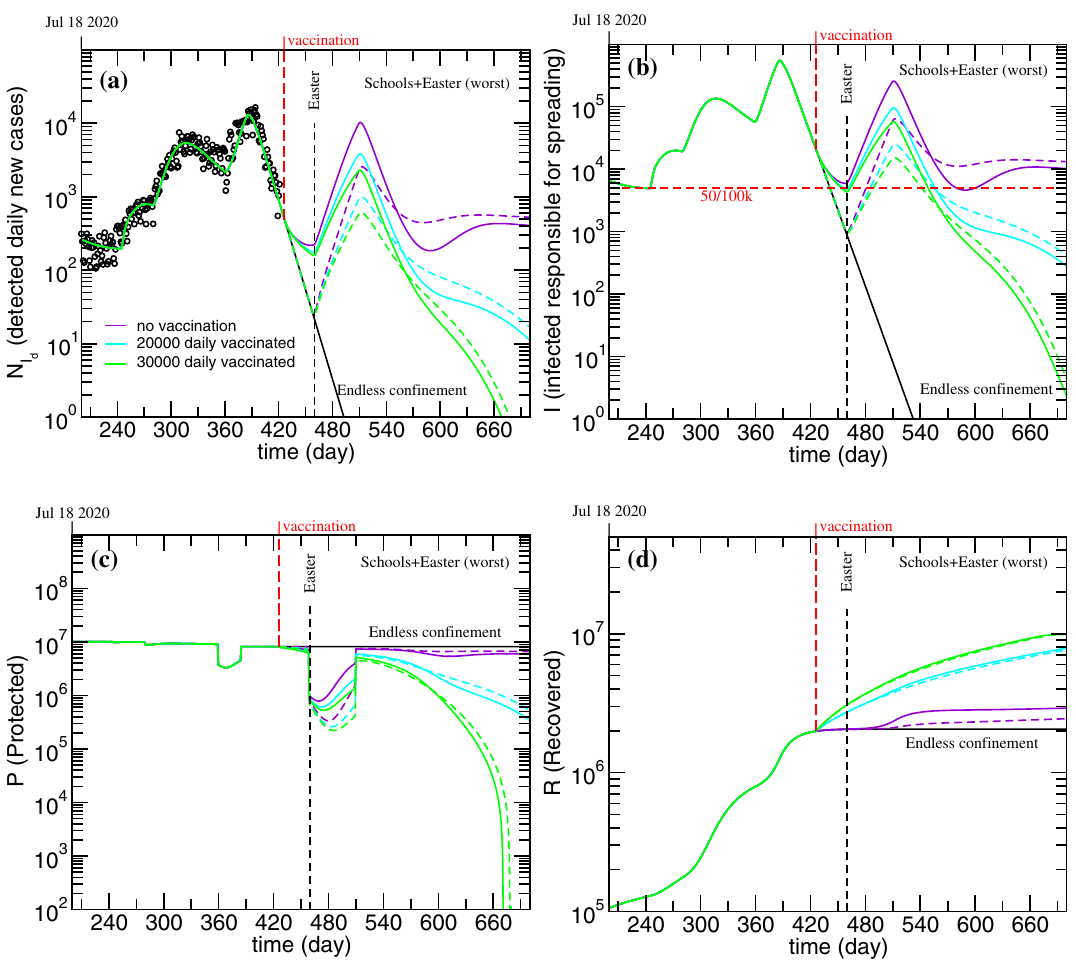
Figure 7. Evolution of the ( a ) detected daily new cases; ( b ) infected non-isolated, responsible for spreading the disease; ( c ) protected and ( d ) Recovered. Worst case presented in Fig. 6 and the effects of different vaccination strategies. Solid lines-schools reopen on March 1; Dashed lines-schools reopen on April